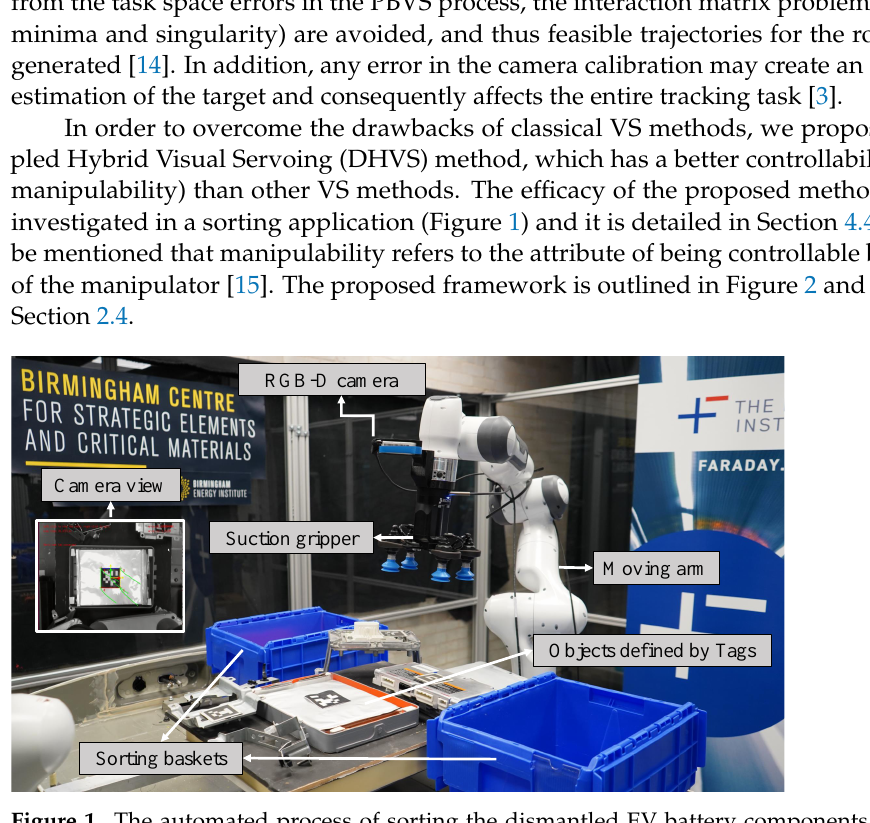
Figure 1. The automated process of sorting the dismantled EV battery components. The object tracking is carried out by the proposed VS method (DHVS) and the object is manipulated using a redundant manipulator